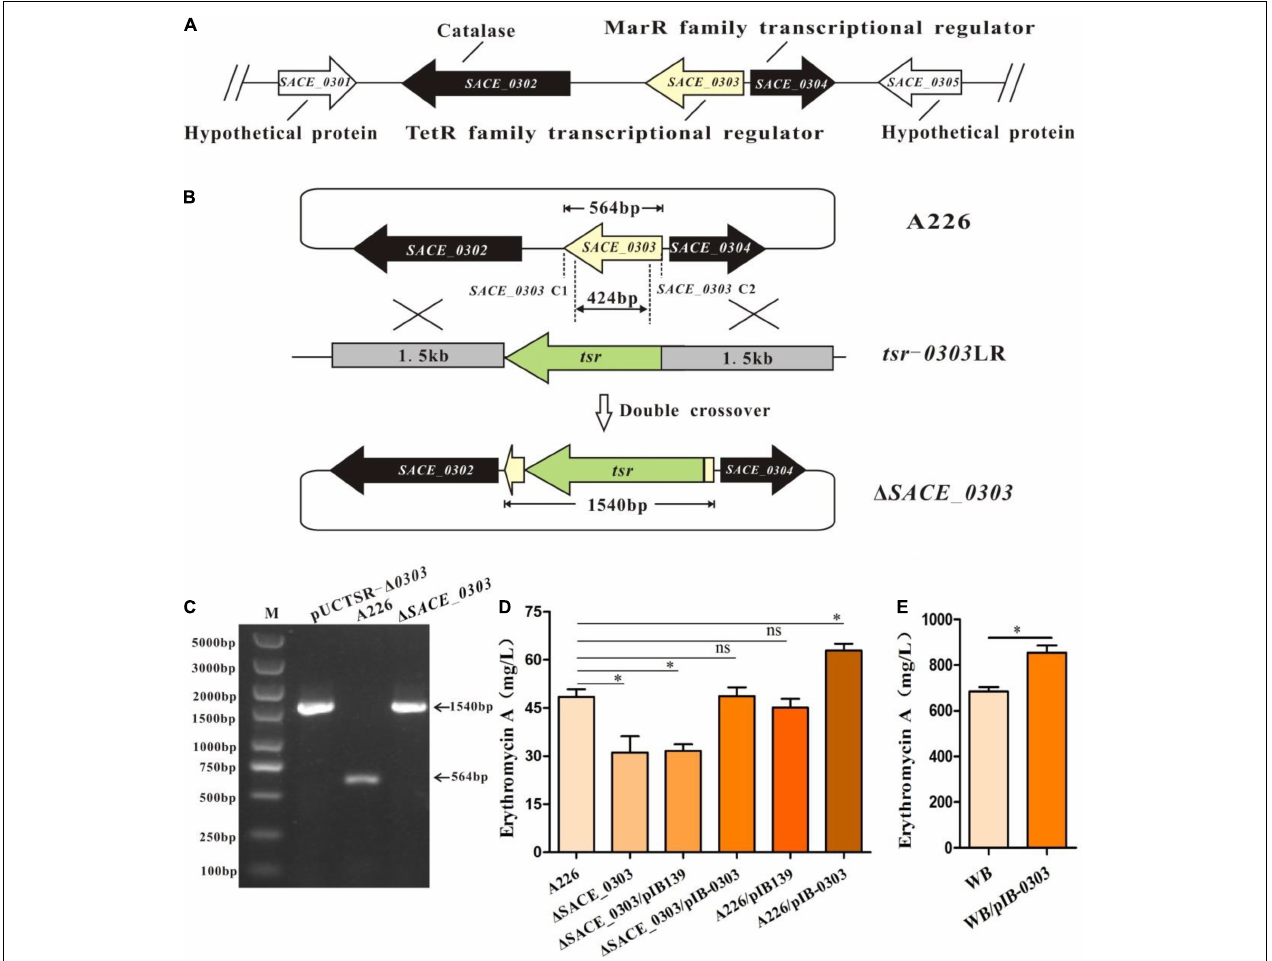
FIGURE 1 | Inactivation of SACE_0303 in Sac. erythraea . (A) SACE_0303 genome location information. (B) Schematic deletion of SACE_0303 by linearized fragment homologous recombination in A226. (C) PCR confirmation of the SACE_0303 deletion mutant by the primers SACE_0303 -C1 and SACE_0303 -C2. The size of gene 564 bp amplified by PCR bands observed in A226, 1,540 bp was detected from pUCTSR- (cid:49) 0303 and (cid:49) SACE_0303 . (D) Er- A yields in A226, (cid:49) SACE_0303 , (cid:49) SACE_0303 /pIB139, (cid:49) SACE_ 0303 /pIB-0303, A226/pIB139, and A226/pIB-0303. (E) Er- A yields in WB and WB/pIB-0303. Error bars (D) : SD from triplicate experiments. Statistical notations (D) : ns, not significant; ∗ p <